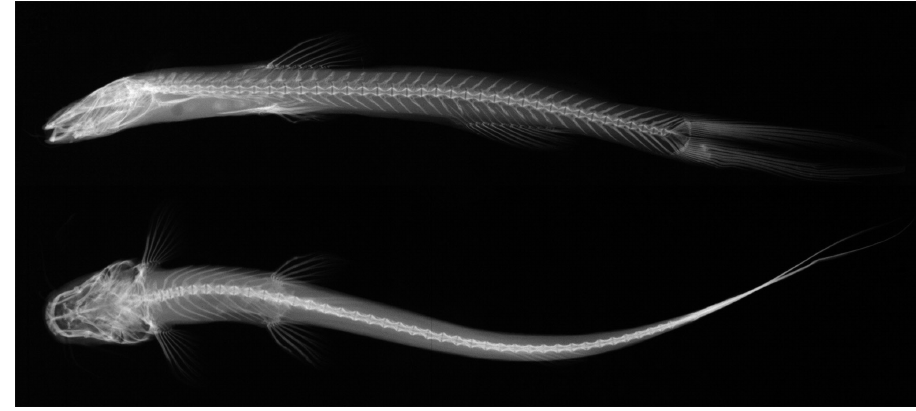
FIGURE 6 | Radiograph images of the holotype of Phenacorhamdia suia , MNRJ 24850, 81.8 mm SL. Lateral (top) and ventral (bottom) views.